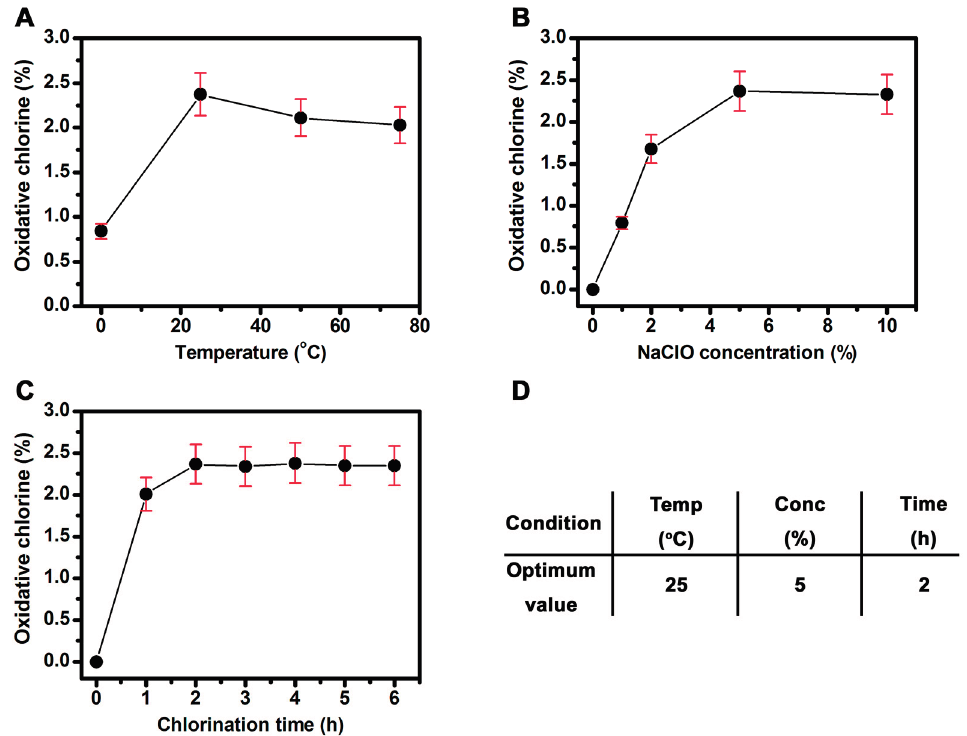
Figure 3. Effect of chlorination temperature ( A ), NaClO concentration ( B ), and chlorination time ( C ) on the oxidative chlorine content in SiO 2 @PS/ N -halamine NPs. The optimal chlorination conditions for preparing SiO 2 @PS/ N -halamine NPs ( D